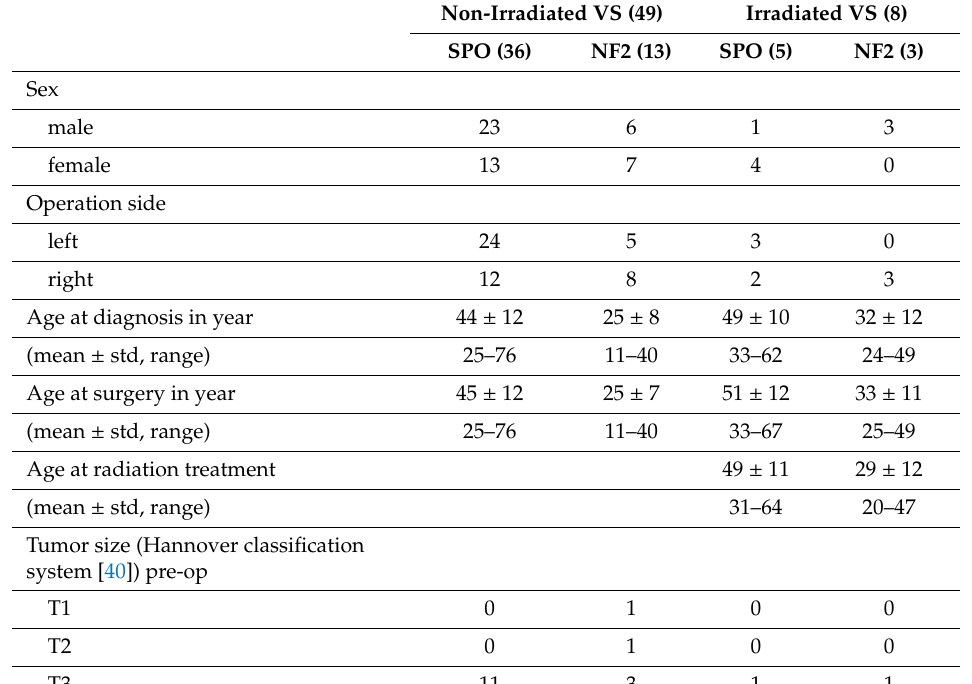
Table 1. Clinical and demographic data of 49 non-irradiated and eight irradiated vestibular schwannomas